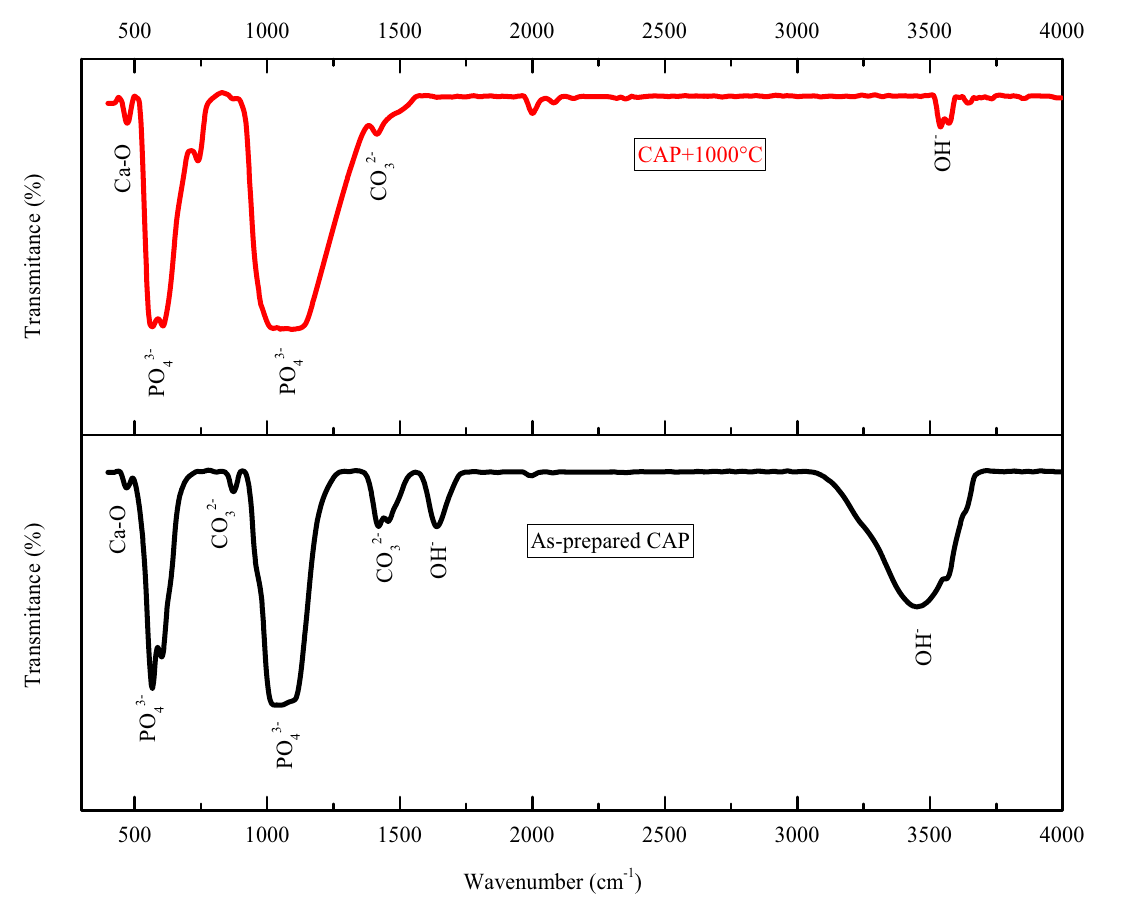
Fig. 5 FT-IR spectral of as-prepared carbonated apatite and heat treated carbonated apatite at 1000